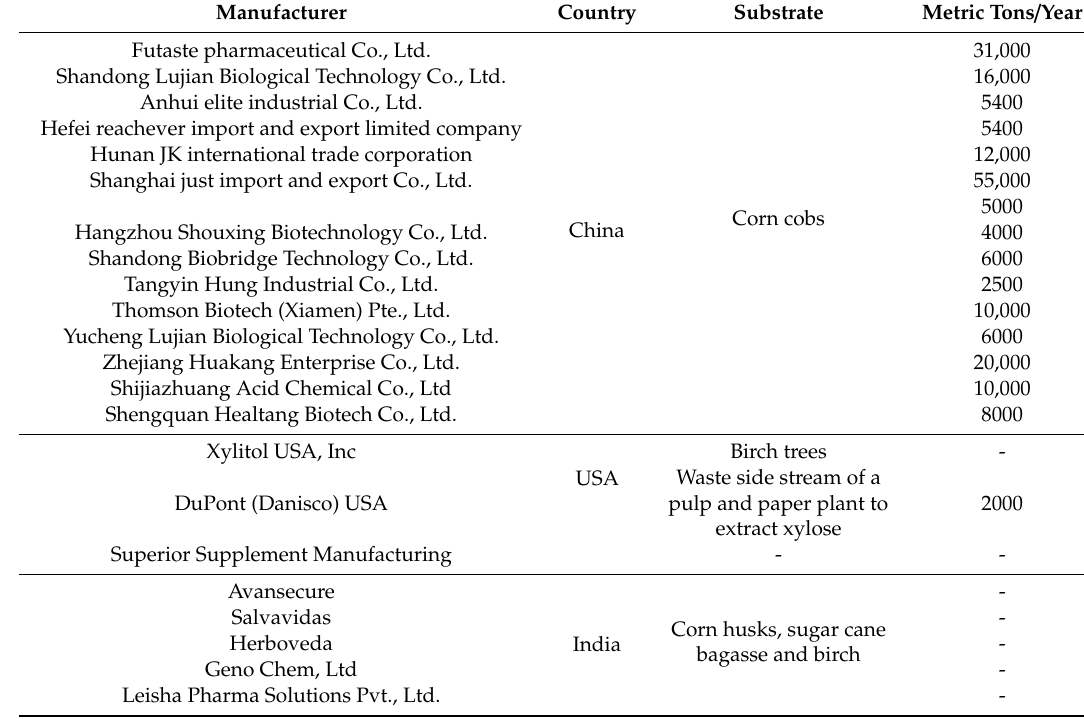
Table 1. Leading manufacturer of xylitol and its production overview in metric tons, as updated on the respective company websites.